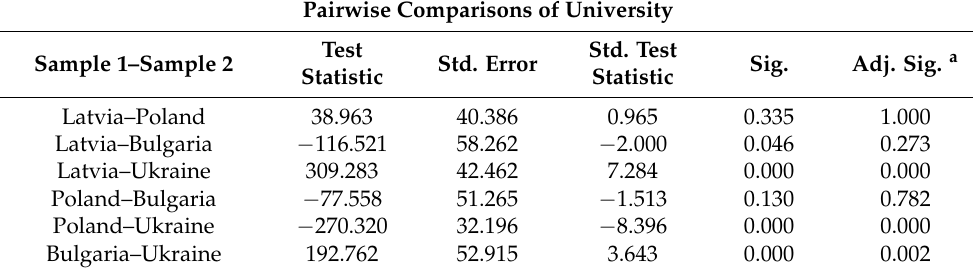
Table 5. Cooperation factor—pairwise comparisons.